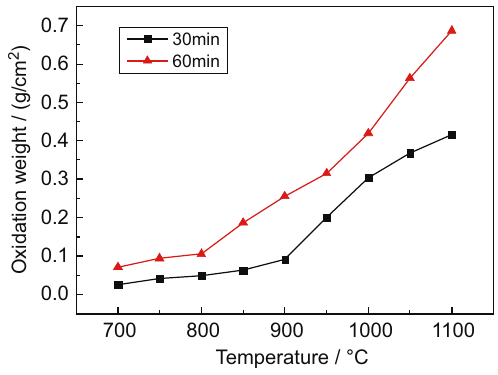
Figure 6: Oxidation weight of steel.